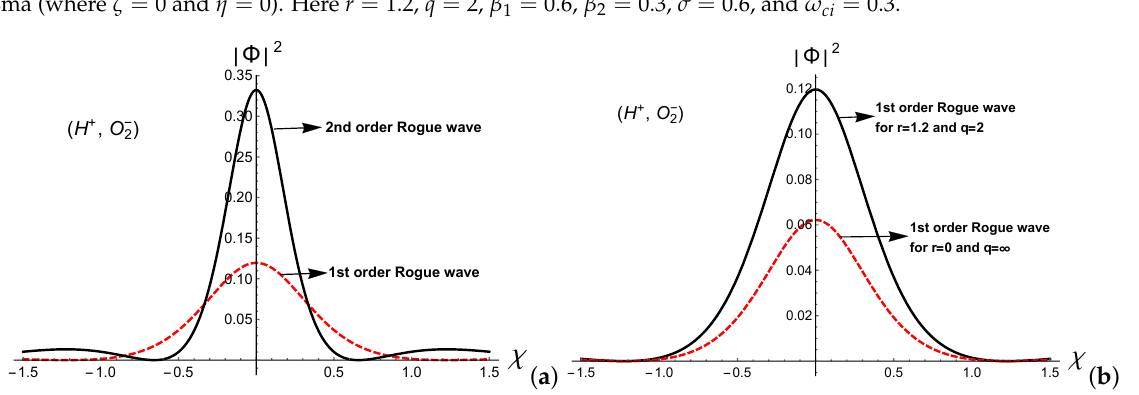
) electronegative plasma. Here β = 0.6, β = 0.3, σ = 0.6, 2 1 2